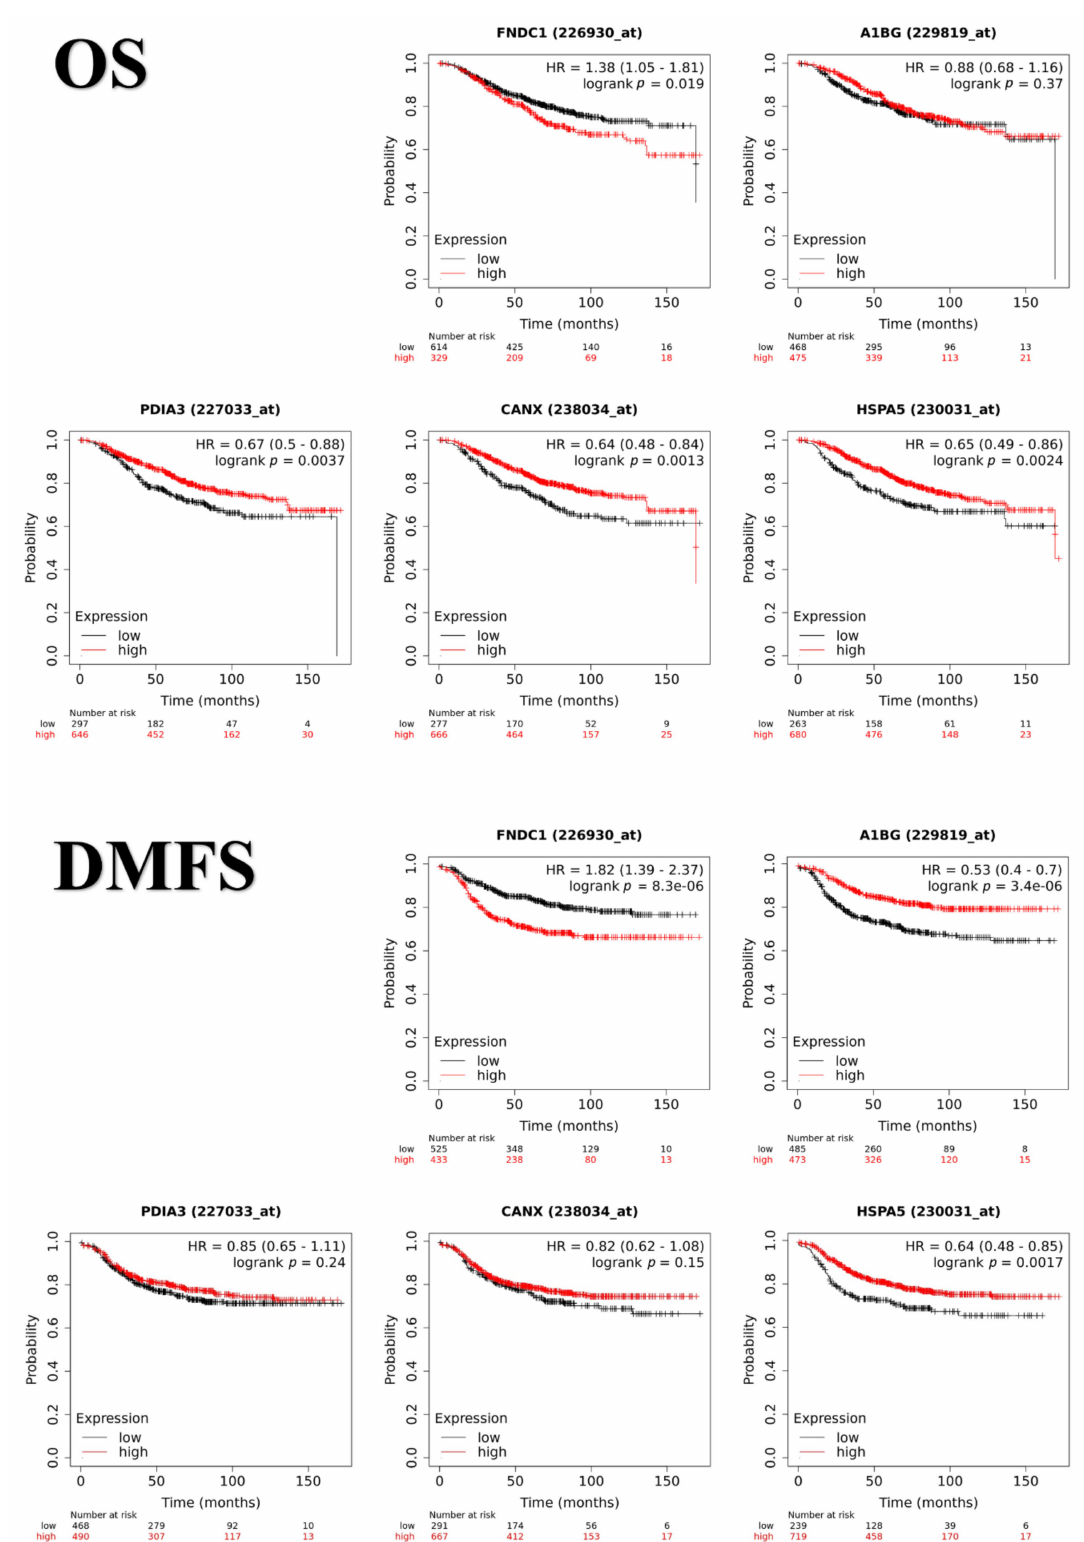
Figure 4. Prognostic values of FNDC1, A1BG, PDIA3, CANX and HSPA5 for OS and DMFS in human breast cancer patients. Gene expression and clinical outcome data were analyzed using Kaplan–Meier plotter. Patients with expression above the threshold are indicated in red line, and patients with expression below the threshold in black line. HR = hazard